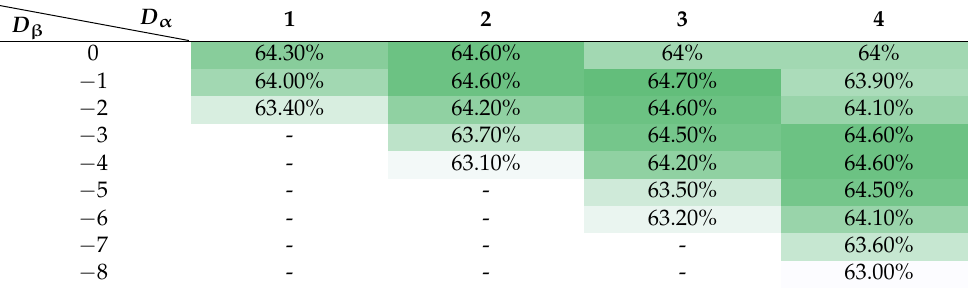
Table 7. The mAP5090 of depth-attentionYOLOv5 at different D α and D β